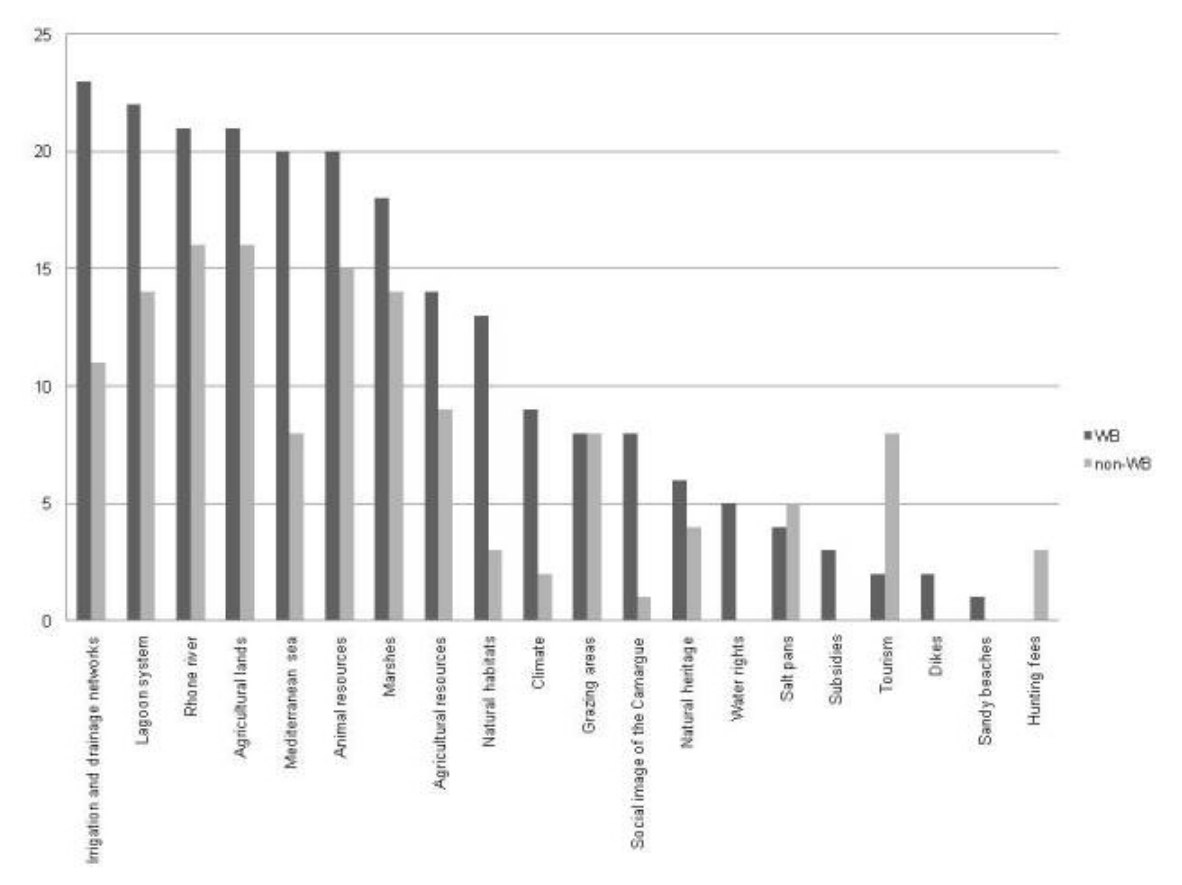
Fig. 3 . Frequency with which members (WB) and nonmembers (non–WB) of the Water Board listed each of the main